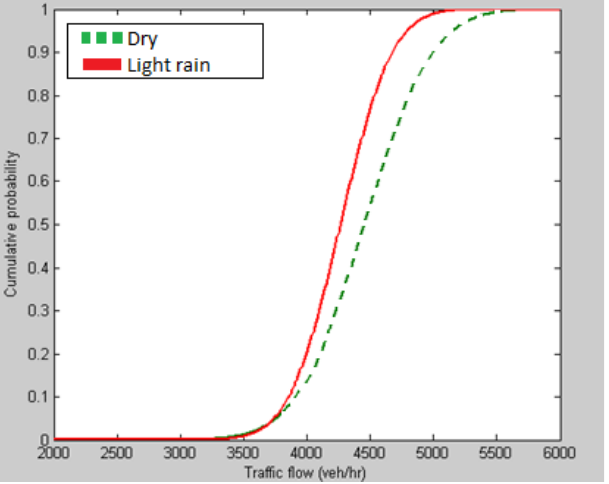
Figure 1. Breakdown probability at motorway A4 in dry and light rain